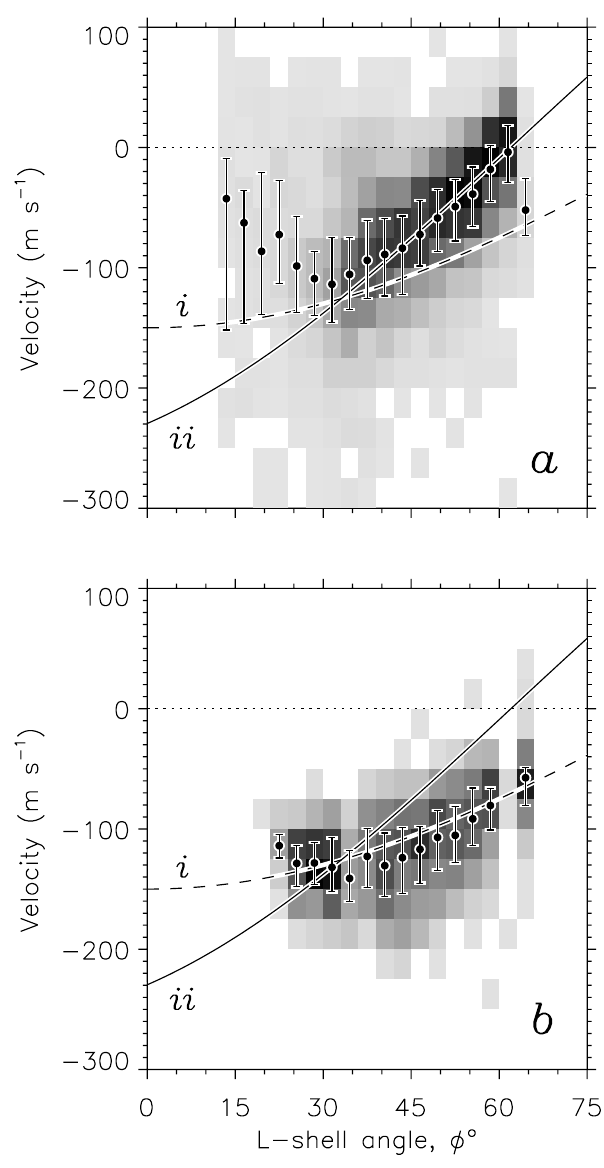
Fig. 9. The density of echoes in φ − v los space for (b) the echoes which comprise the radar arc and (a) all other echoes. The grey scale shows the density of echoes on a linear scale, self-normalized. The dots and bars show the median and upper- and lower-quartiles of the distributions in 3 ◦ wide bins of L-shell angle. The dashed and solid curves show the v los cosine dependence on φ expected for flows of (i) 150m s − 1 aligned eastwards along the local L-shell and (ii) 260m s − 1 oriented at 28 ◦ clockwise from the L-shell direction, respectively.